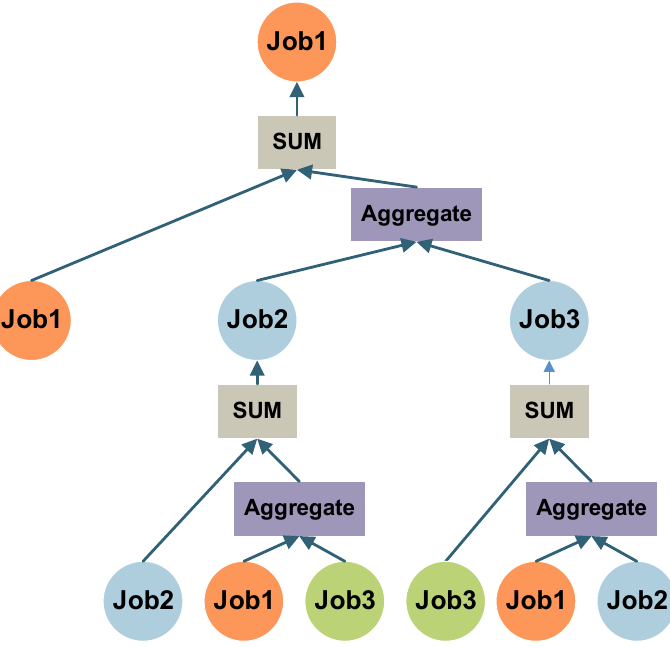
Figure 6. The information aggregation of GIN.